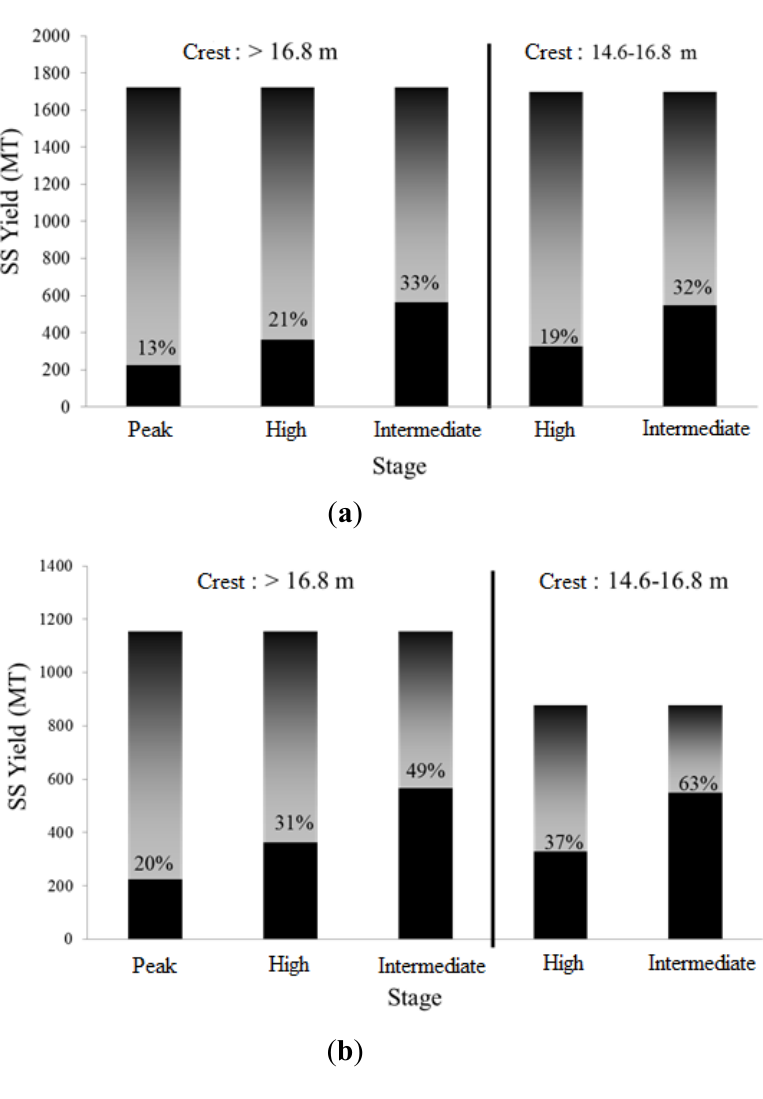
Figure 4. Percent averages for Peak Flow and High Flow Years as a percentage of total suspended sediment yield ( a ) and total flood suspended sediment yield ( b ). Horizontal axis categories correspond to different stage categories during the flood.